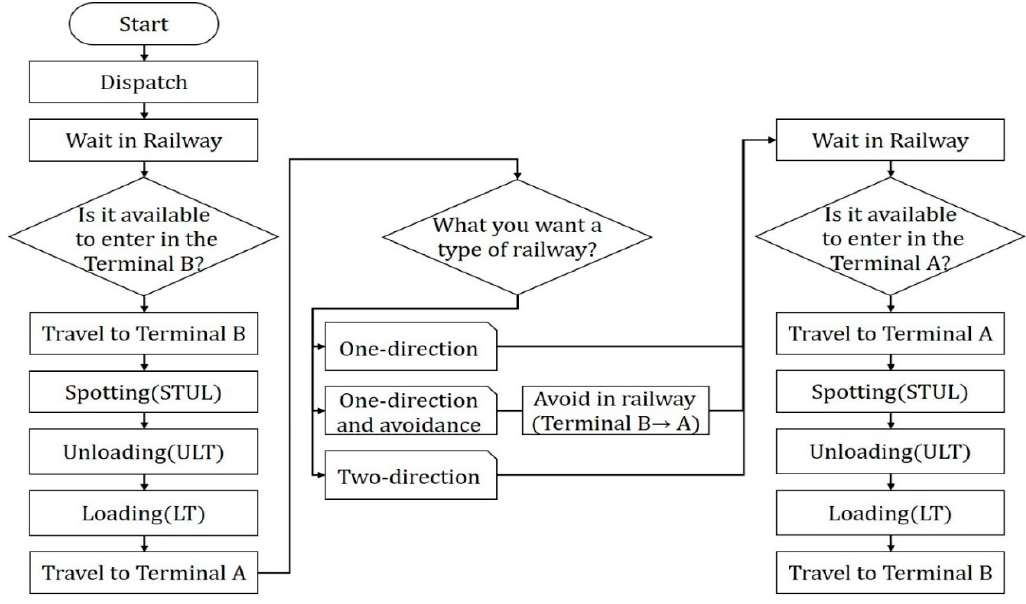
Figure 6. ACTS freight car operation algorithm.